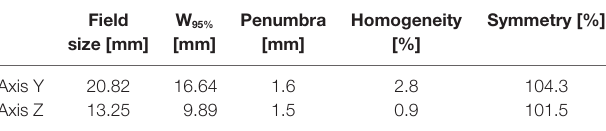
TABle 2 | Field parameters measured with the EBT3 film along the X- and Y-axis.